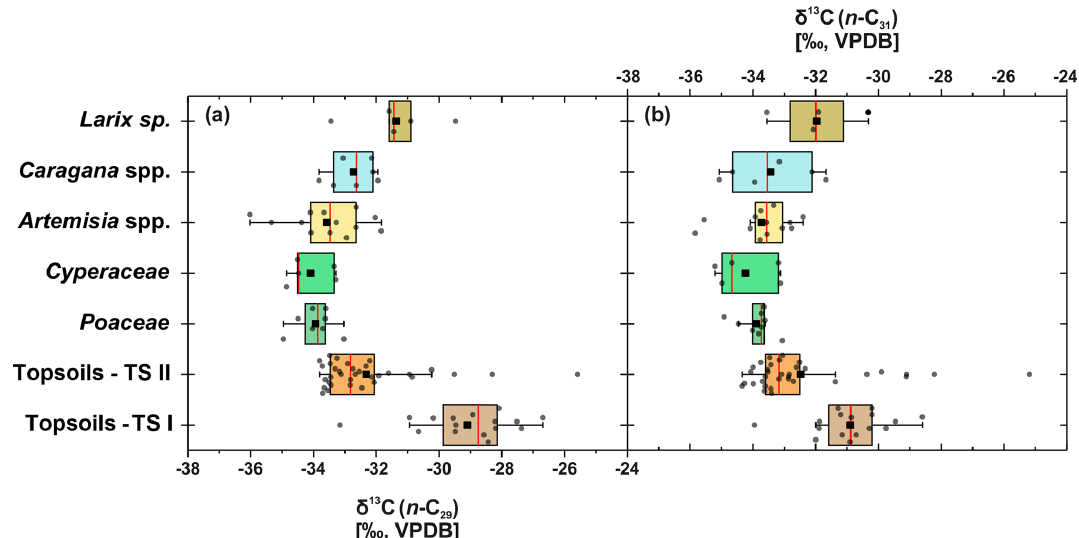
Figure 5. Compound-specific δ 13 C of plants and topsoils from Mongolia. (a) Compound-specific δ 13 C 29 ( n : Larix sp. = 5, Cyperaceae = 5, Poaceae = 8, Caragana spp. = 7, Artemisia spp. = 13, topsoils TS I = 16, topsoils TS II = 34). (b) δ 13 C 31 ( n : Larix sp. = 4, Cyperaceae = 5, Poaceae = 9, Caragana spp. = 6, Artemisia sp. = 13, topsoils TS I = 16, topsoils TS II = 34). The boxplots indicate median values (red lines), mean values (black squares), interquartile ranges with lower (25%) and upper (75%) quartiles (box), outlier (whiskers), and investigated samples (grey circles). See Table 1 for